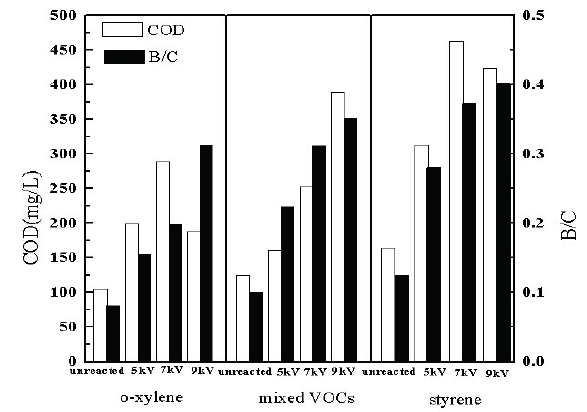
Figure 10. Biodegradability of byproducts.